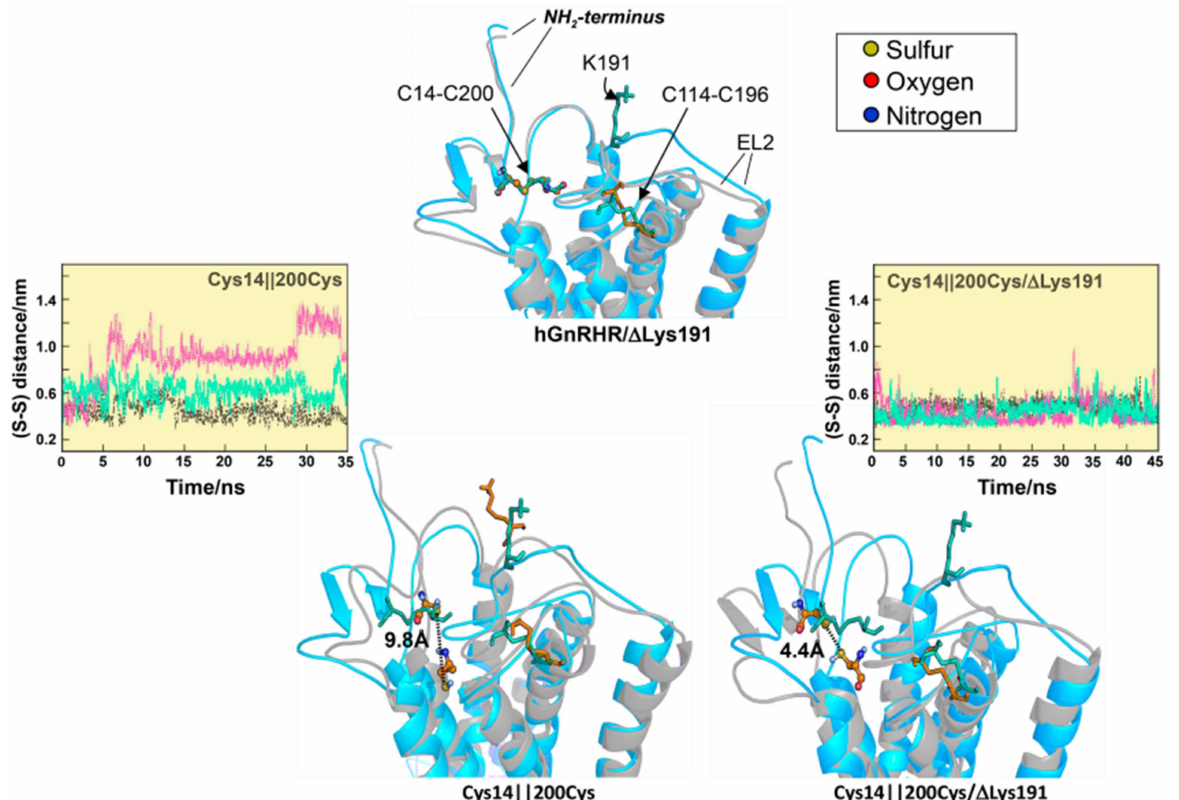
Figure 3. Changes in sulfur-sulfur (S-S) distances between C14 and C200 in the hGnRHR when the C14–C200 is disrupted (||) in silico, in the presence and absence of K191. Superposition of the WT hGnRHR conformation (blue structures) and the final mutant conformations (grey structures) are shown. Lysine 191 and the C14–C200 and C114–C196 disulfide bridges of the WT hGnRHR are highlighted in blue (or orange in the mutants). Residues C14 and C200 are depicted in balls and sticks. S–S distances between residues in positions 14 and 200 are also indicated (dotted lines). Insets: distances (in nm) between S-S atoms as a function of time for 3 replicas. Observe that larger average distances are found in mutants bearing K191 (for original data and details see Ref.